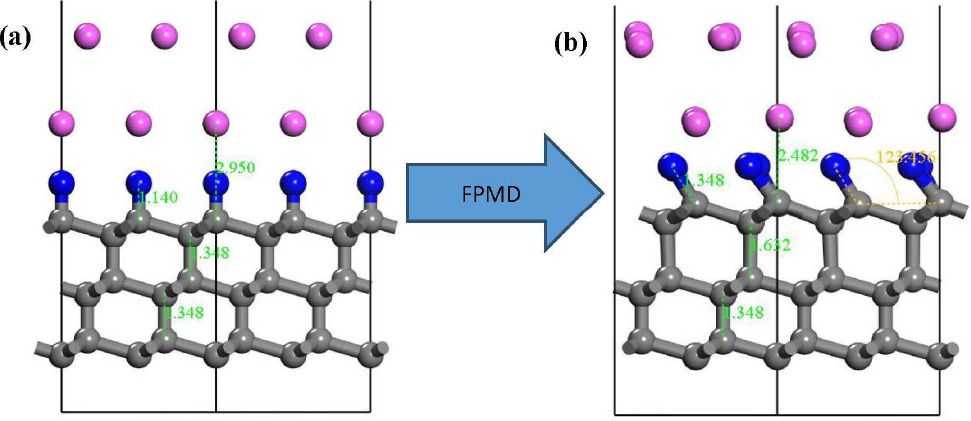
Figure 7. The a-C/Al interface model: ( a ) initial model and ( b ) optimized model.